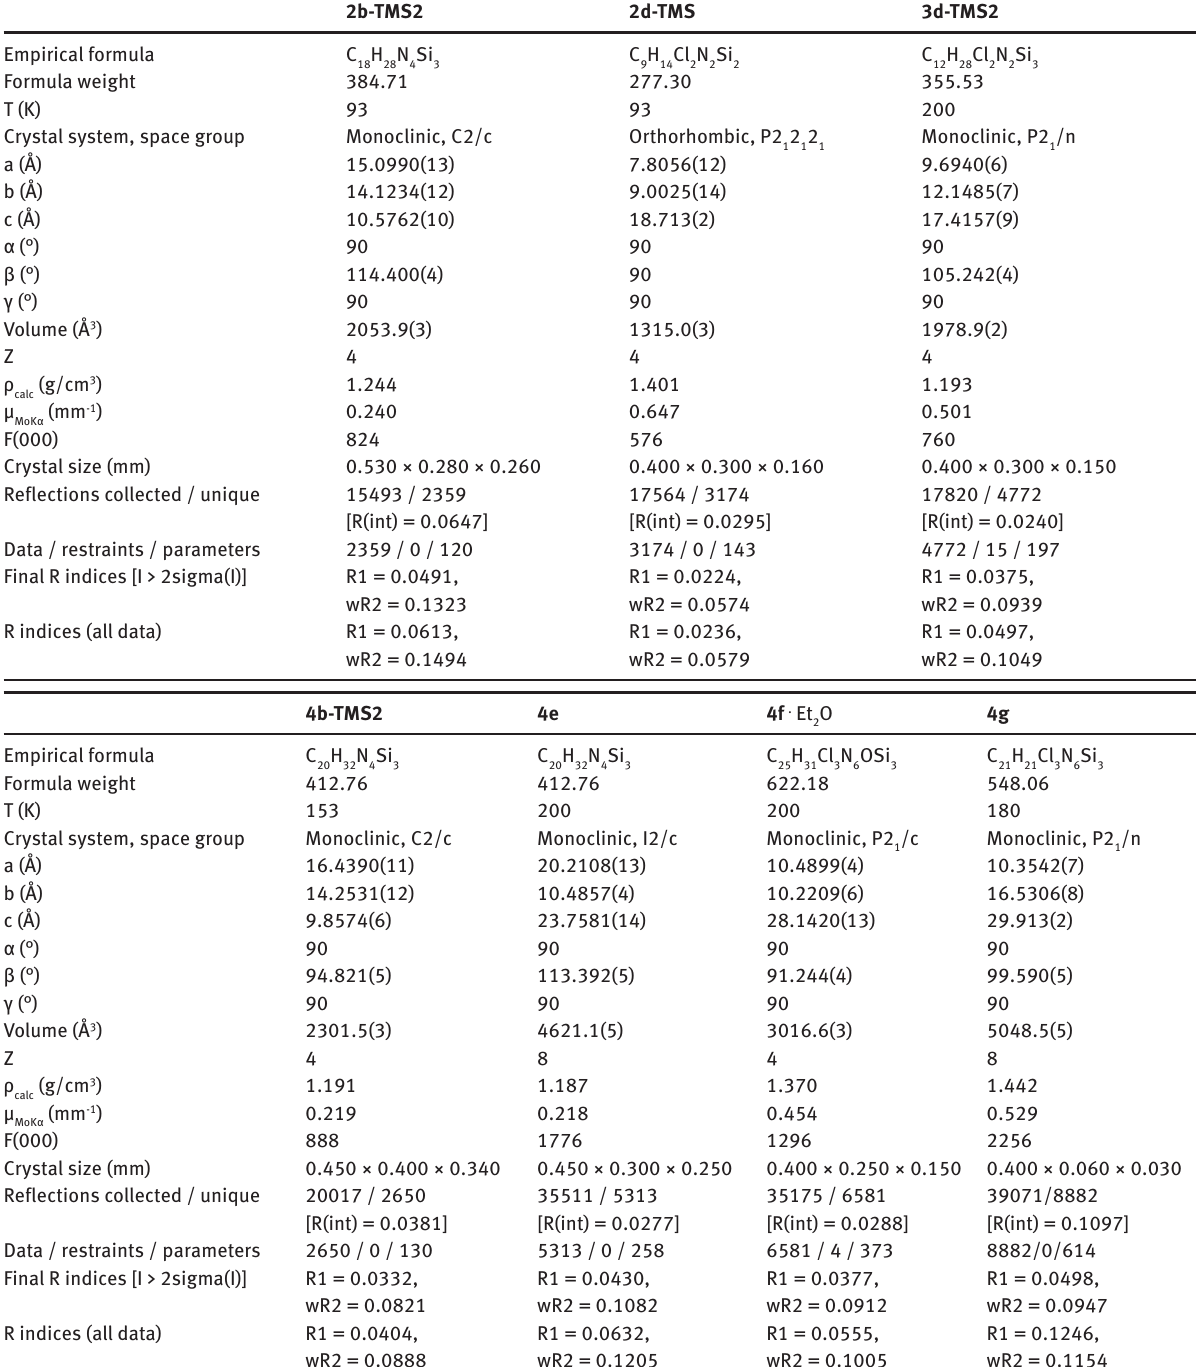
Table 11: Crystal data and structure